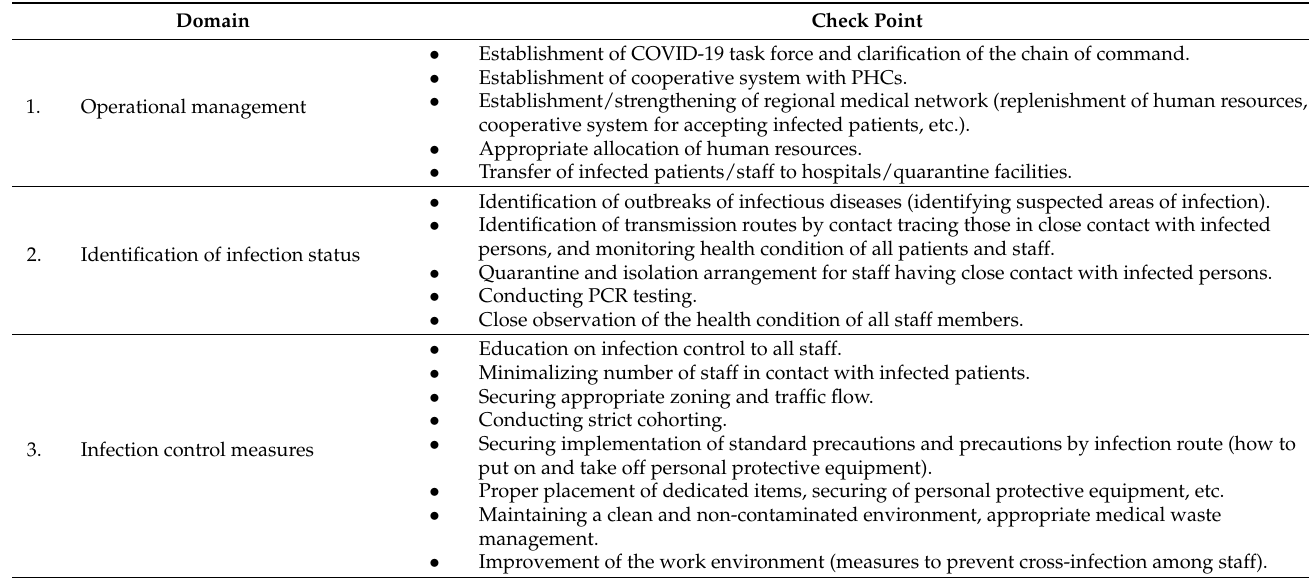
Table 2. Analytical framework.